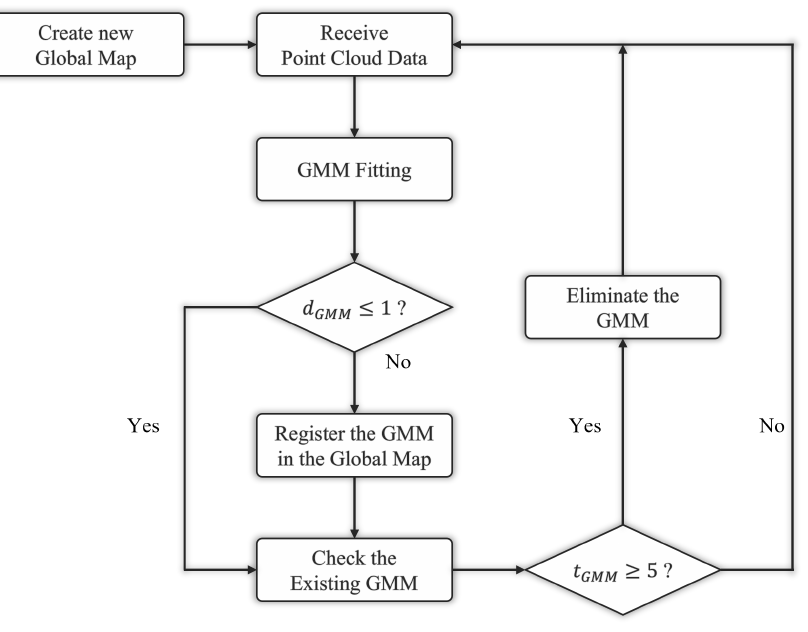
Figure 3. Process flow of global map